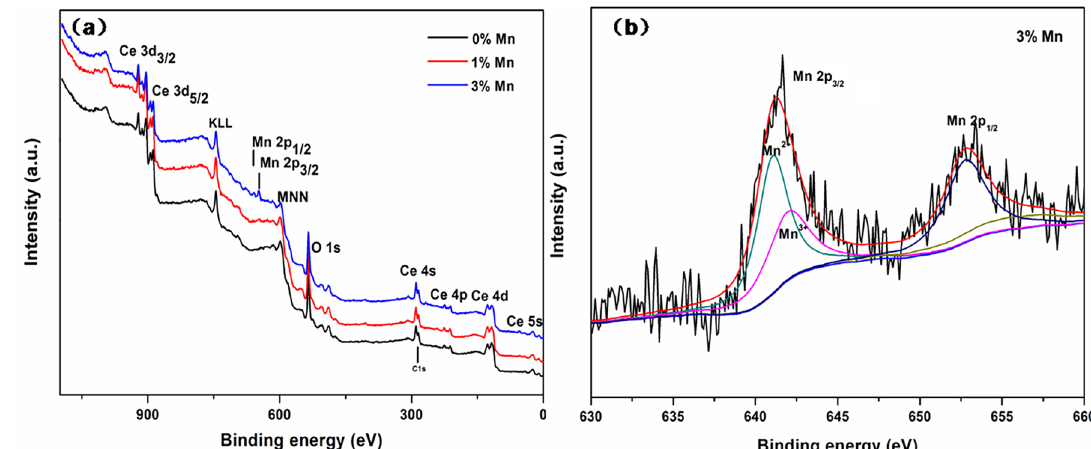
with varying Mn/Ce molar 2